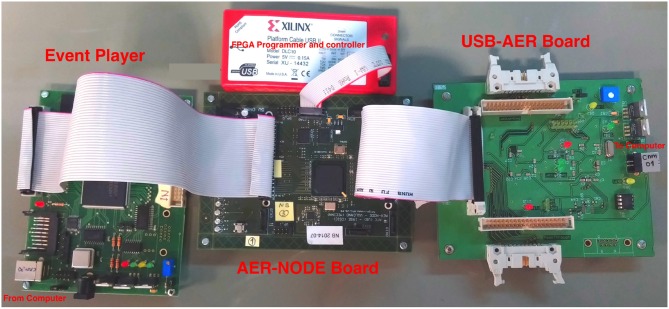
Hardware setup for demonstration of on-line real-time Stochastic Binary-Weights STDP learning. This setup contains an Event-Player (USBAER board) (Serrano-Gotarredona et al., 2009) to play back recorded AER events with precise timing, an AER-NODE board (Iakymchuk et al., 2014) which contains the Spartan-6 (XC6SLX150T-3) FPGA and a computer interfacing board (USBAERmini2) (Serrano-Gotarredona et al., 2009) to send the output AER events along with their time-stamps to a computer through USB. The computer uses jAER (Delbruck, 2007) to visualize and/or record events in real time displaying them as sequences of frames on a monitor screen.